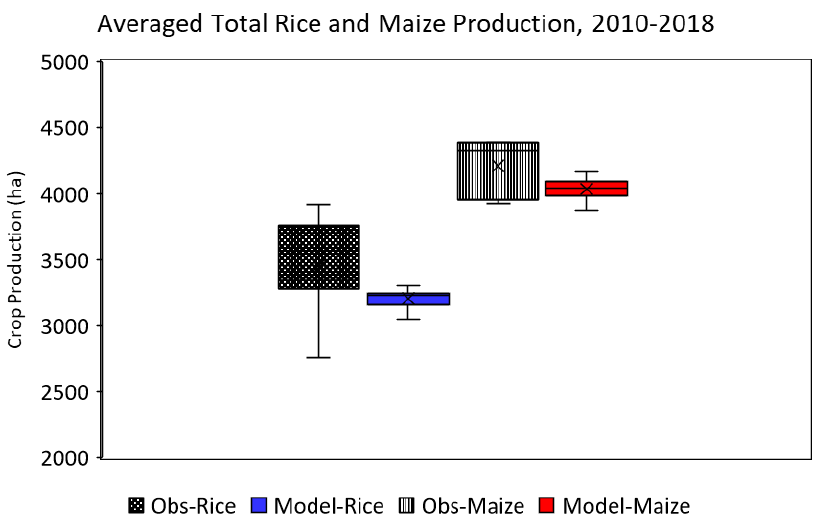
Figure 3. Box plot of simulated rice and maize from the Decision Support System for Transfer (DSSAT) and on-farm Agrotechnology Transfer (DSSAT) and on-farm datasets.